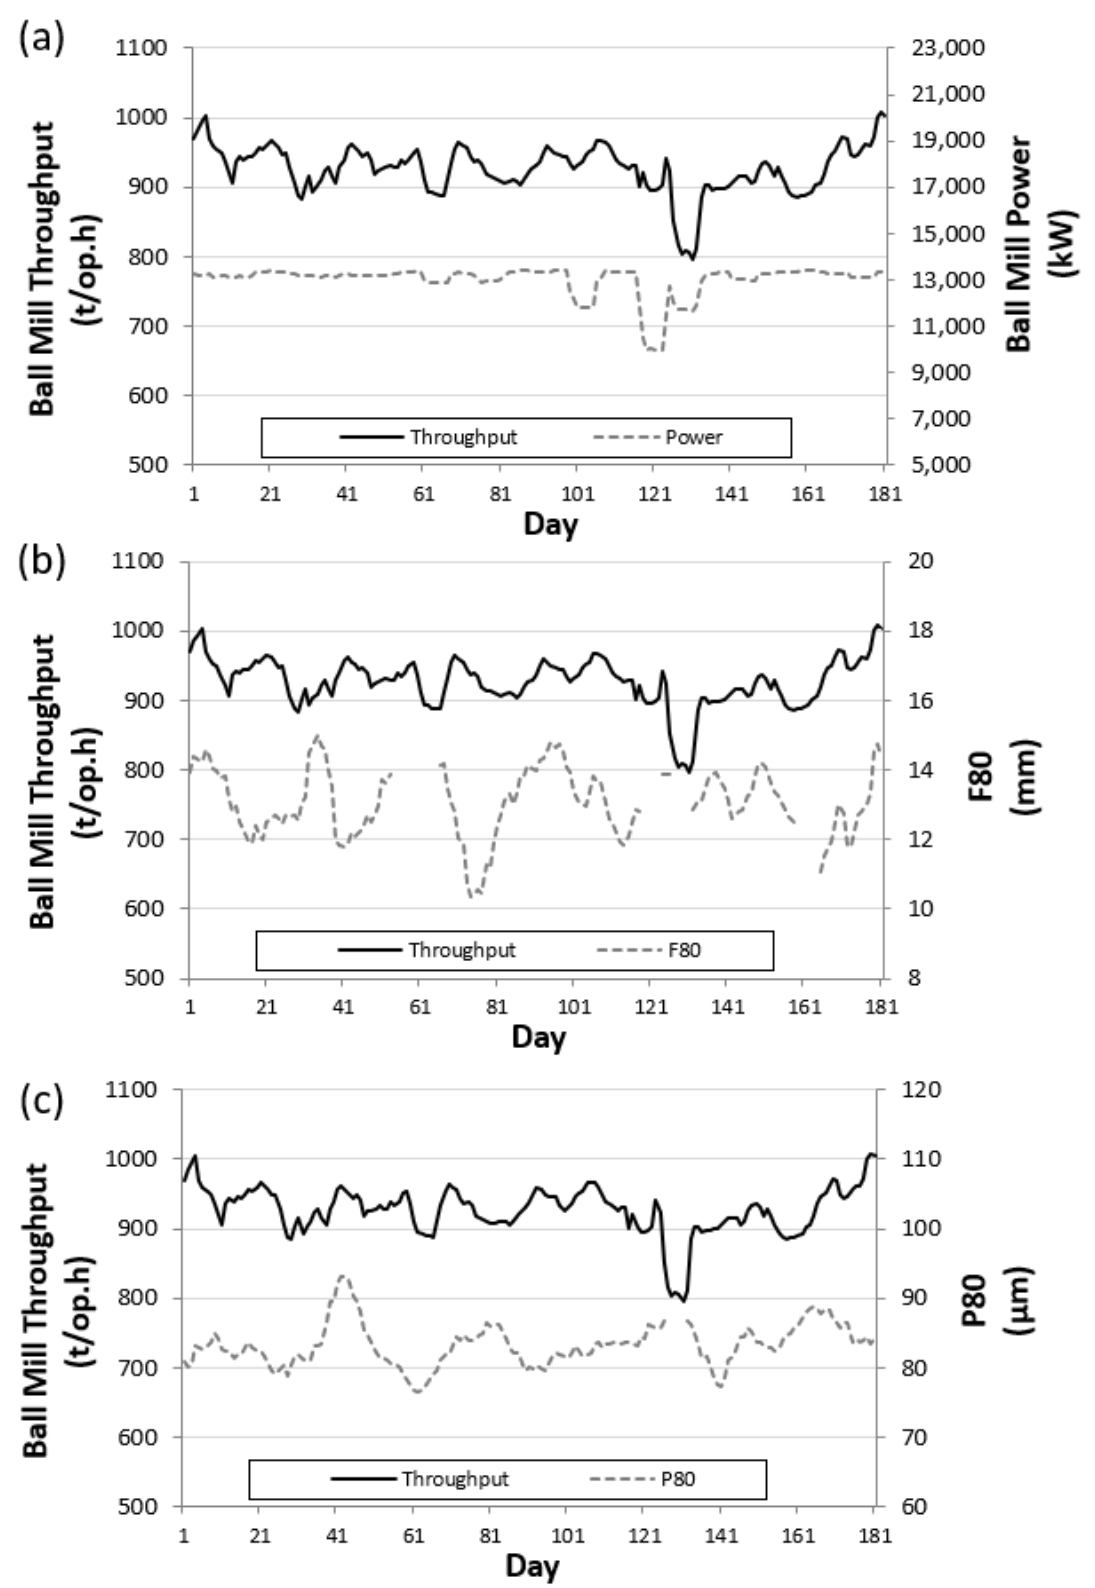
Figure 7. Moving average (7 days) of ball mill throughput compared to moving average of ( a ) ball mill power ( b ) feed particle size: (F80), and ( c ) product particle size (P80).